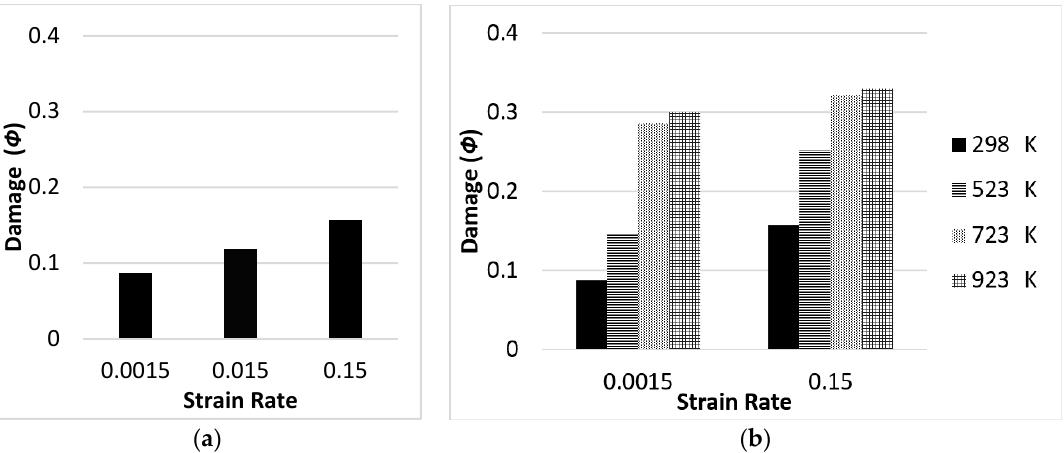
Figure 8. Average damage at ( a ) room and ( b ) high temperatures for different strain rates.